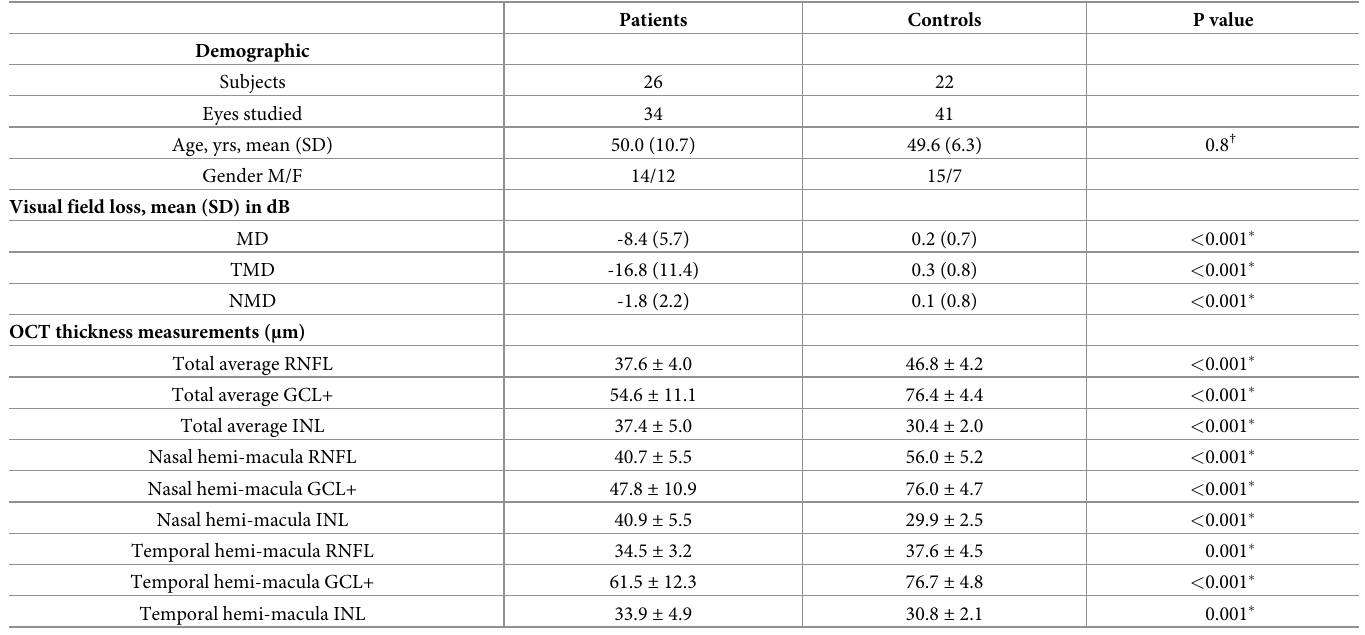
Table 1. Demographic variables in patients and controls along with visual field and optical coherence tomography findings in the eyes